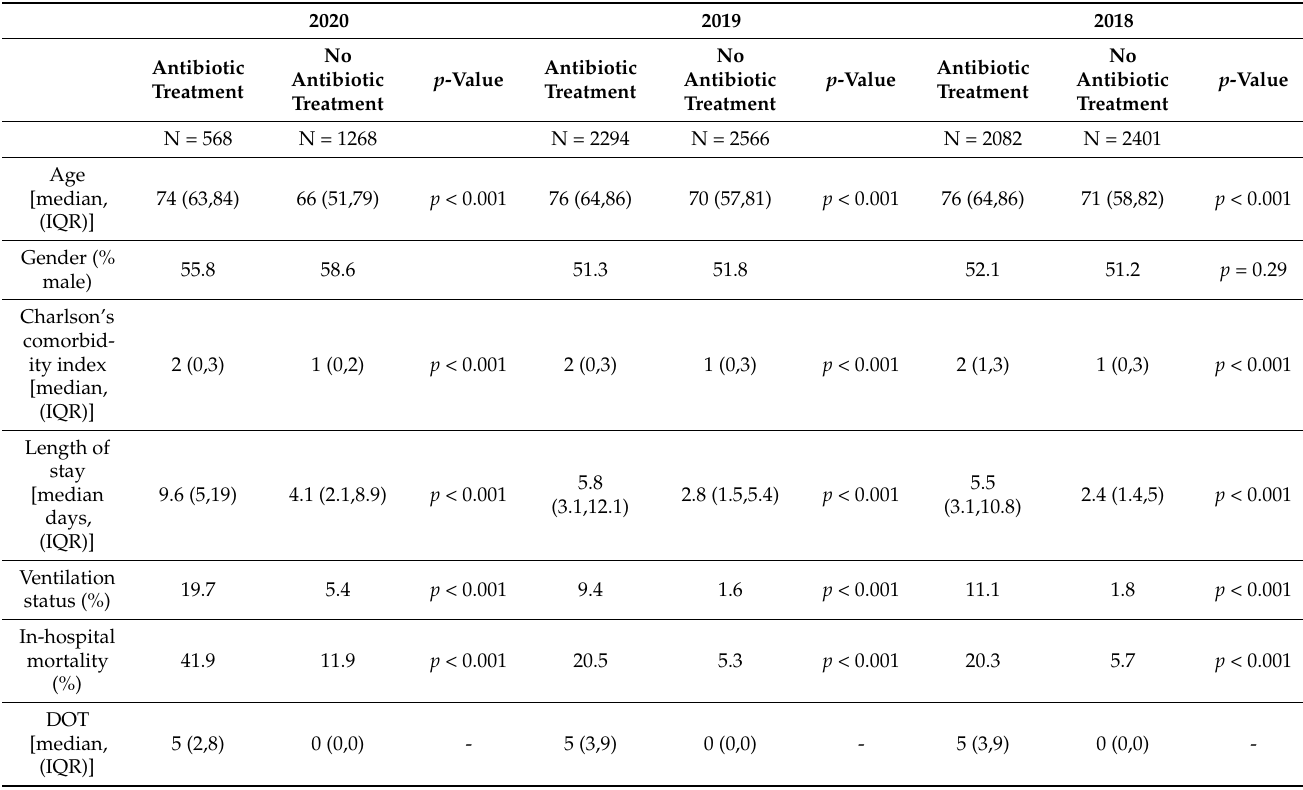
Table 2. Comparison between treated and nontreated